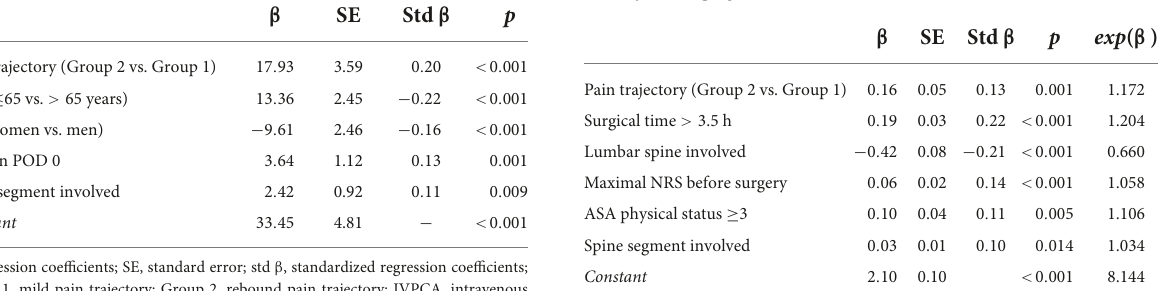
TABLE 3 Predictors of total IVPCA consumption after spine surgery. TABLE 4 Factors associated with length of hospital stay (LOS)* after spine